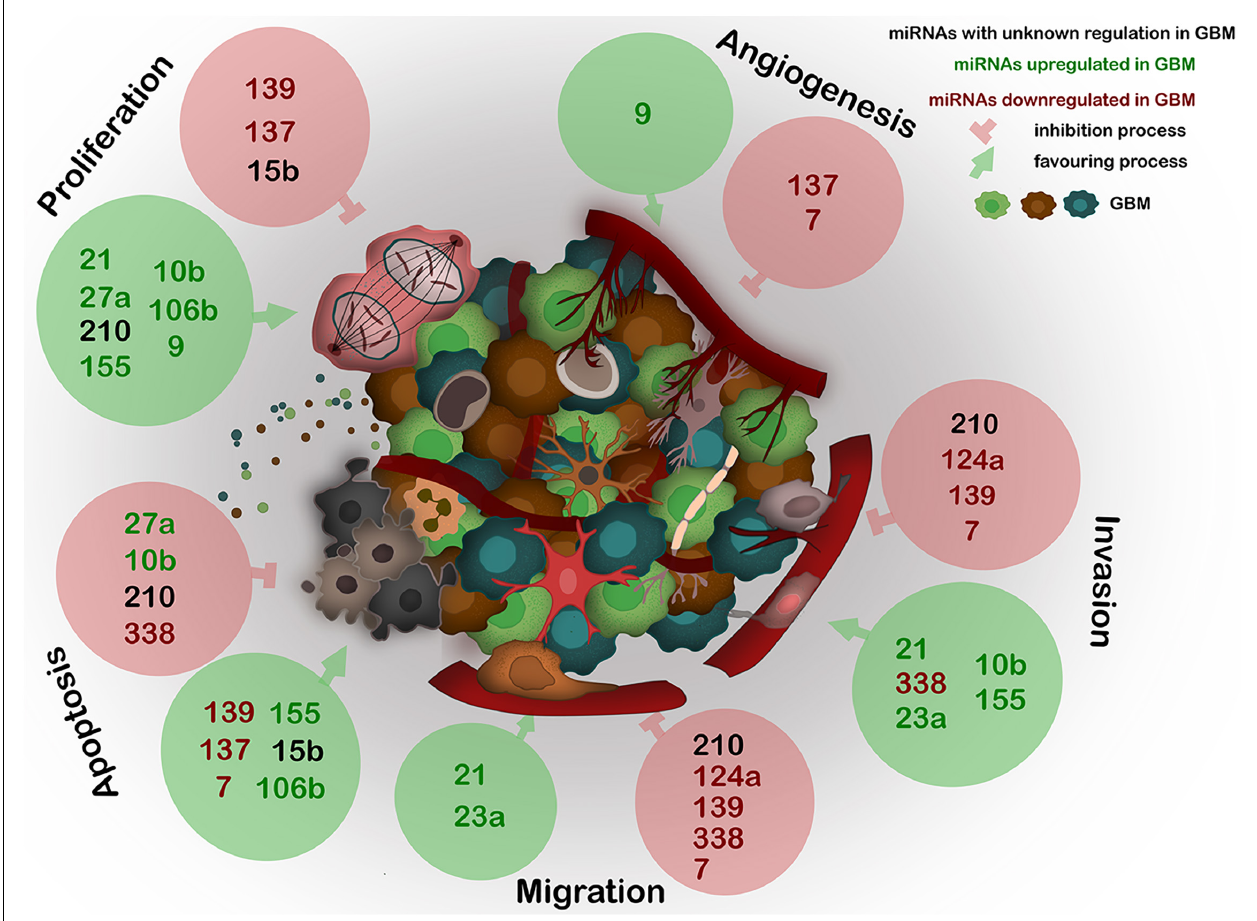
FIGURE 2 | Expression of the most deregulated miRNAs in GBM and their influence on proliferation, angiogenesis, invasion, migration, and apoptosis of GBM. miRNAs, frequently carried by EVs, act as epigenetic modulators and regulate several key processes in GBM. The deregulation of any of these miRNAs generates abnormal gene expression which leads to disease progression. Black – miRNAs with unknown regulation in GBM; green – miRNAs upregulated in GBM; red – miRNAs downregulated in GBM. Green circles show miRNAs positive effect on described processes; red circles show miRNAs negative effect on described